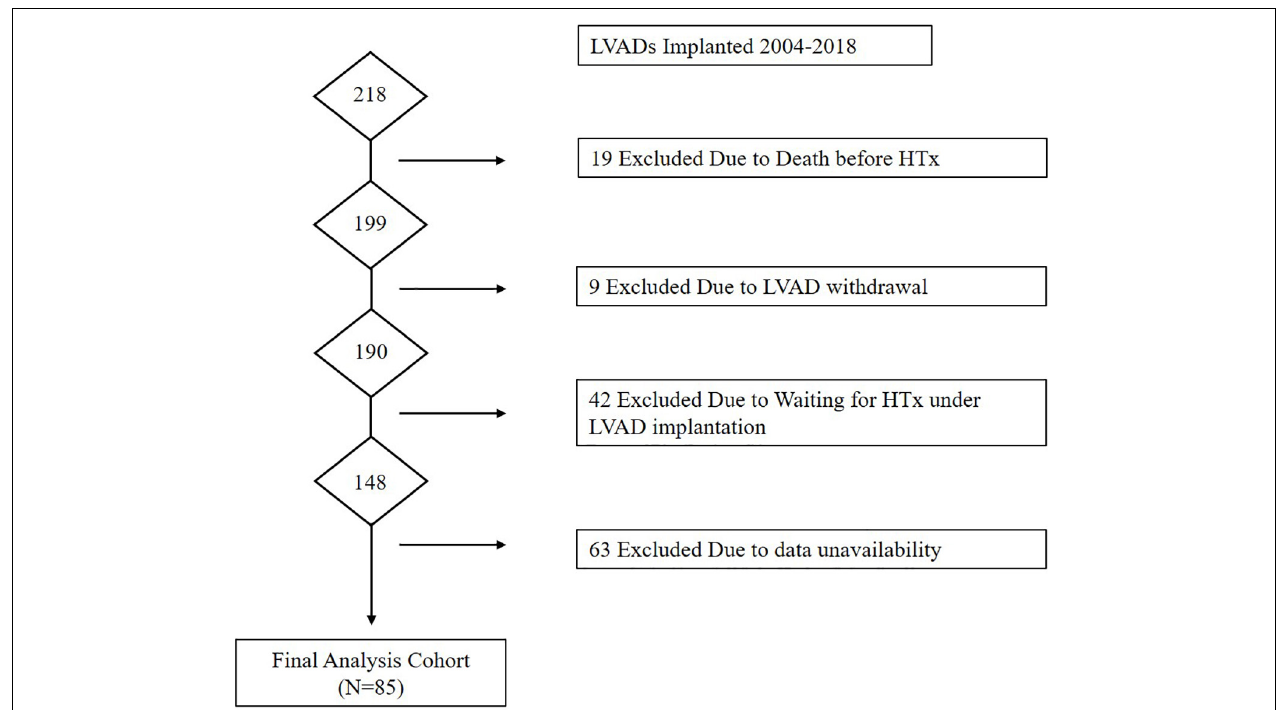
FIGURE 1 | Flow of patients through the Study. HTx, heart transplantation; LVAD, left ventricular assist